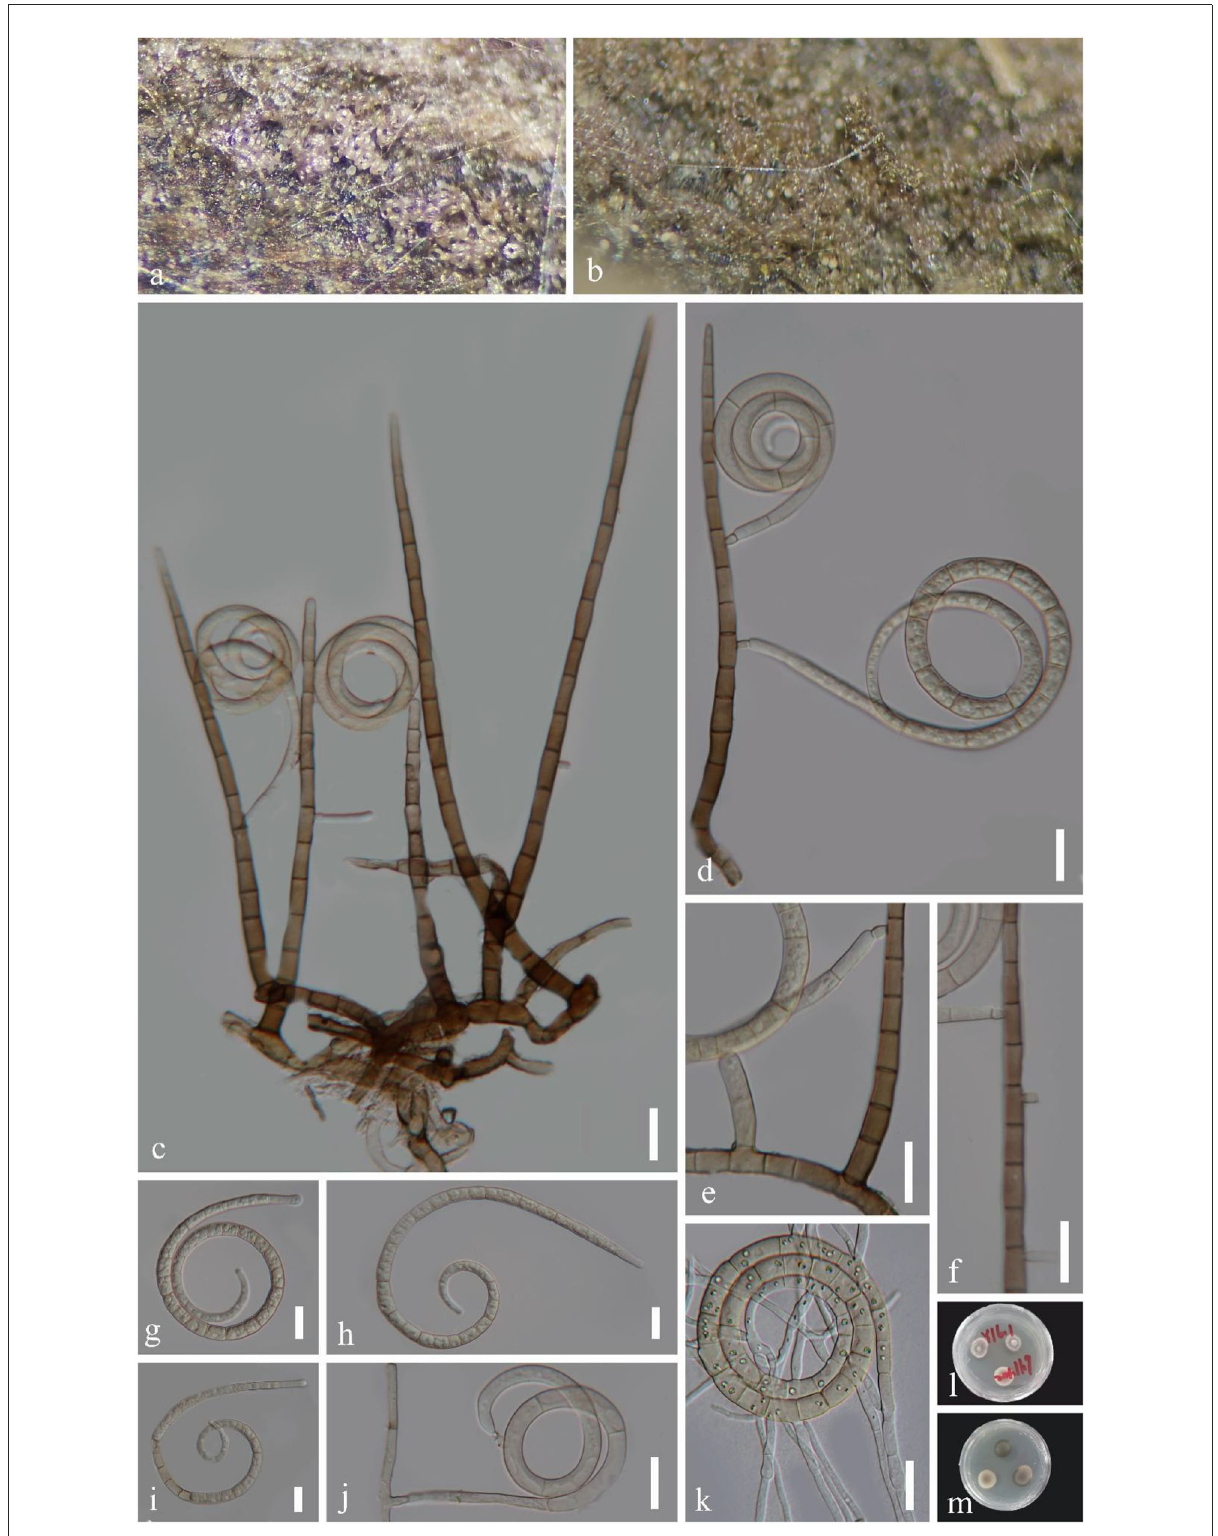
FIGURE4 Helicoma longisporum (GZAAS 22-2005). (a,b) Colony on decaying wood. (c,d) Conidiophores with attached conidia. (e,f,j) Conidiogenous cells. (g–i) Conidia. (k) Germinating conidium. (l,m) Colonies on PDA observed from above and below. Scale bars: (c–k) = 20 µ